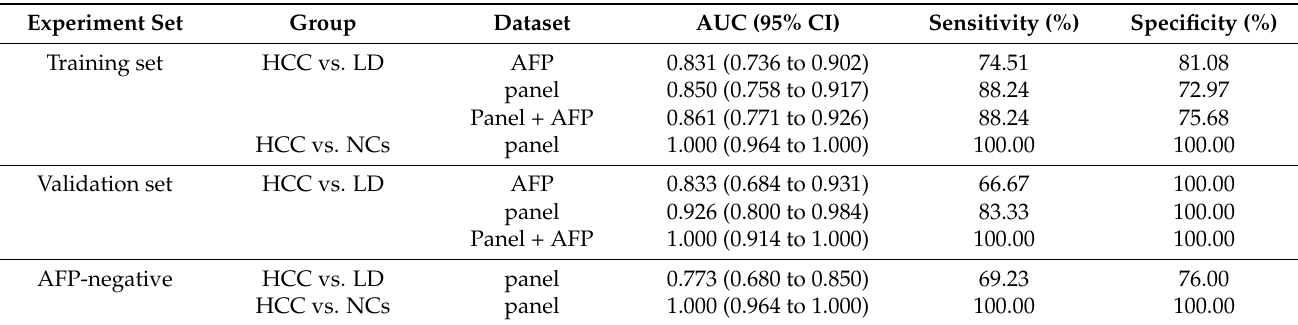
Table 5. Test performance characteristics for the signature panel.